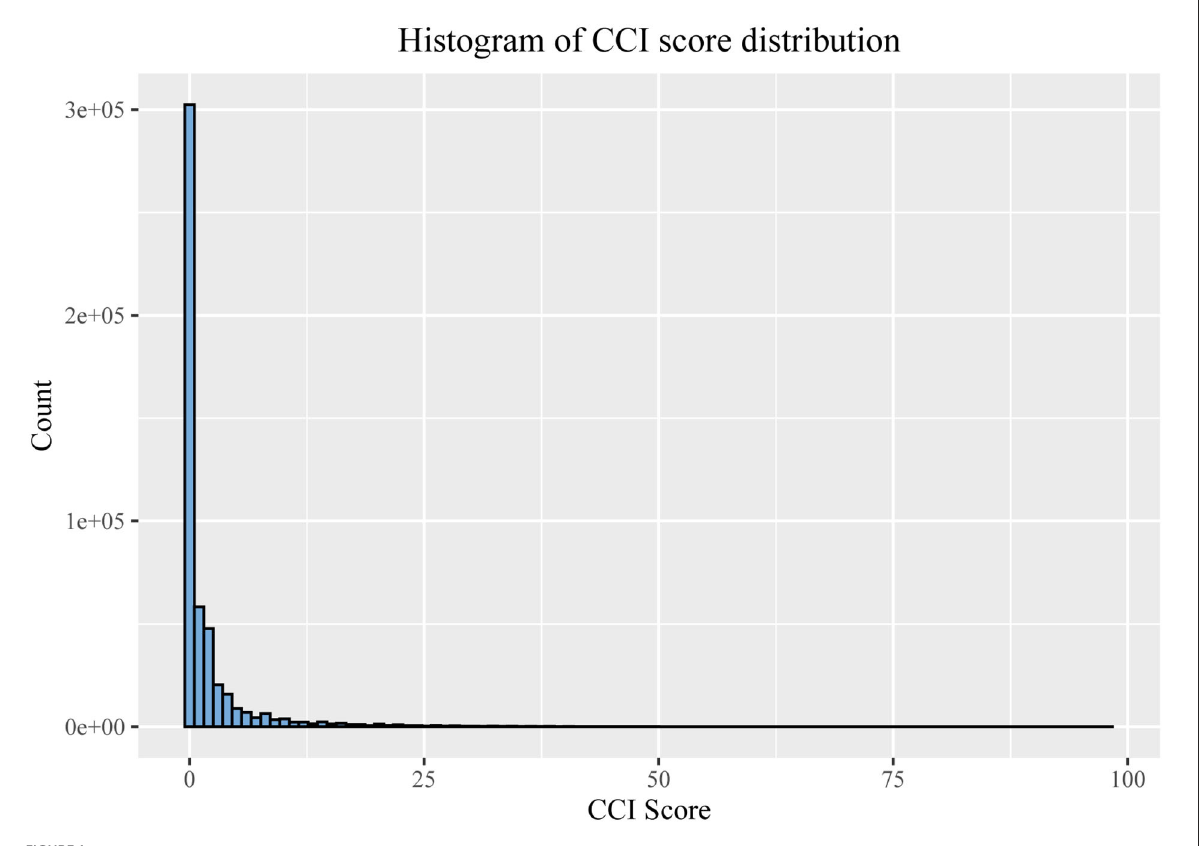
FIGURE1 Distribution of different CCI